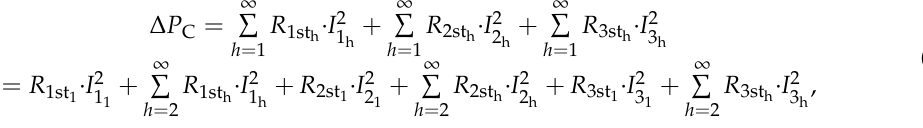
42/7: ( a ) the length of 5 km; ( b ) the length of 30 km.